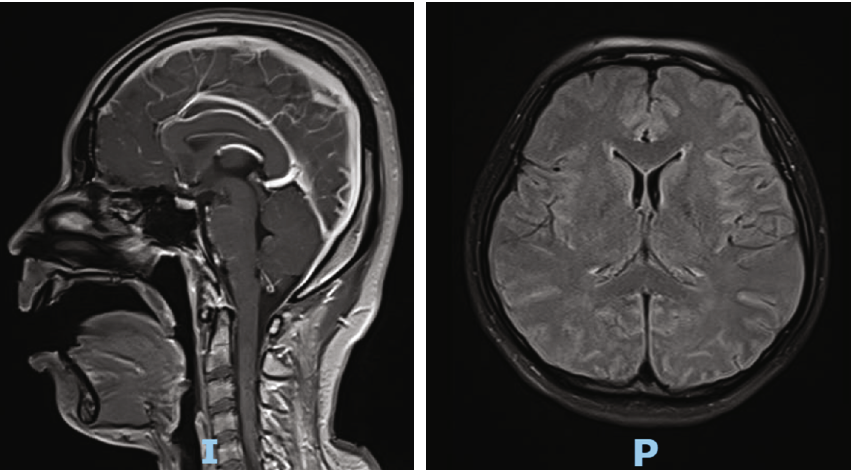
Figure 1: Brain magnetic resonance imaging on the same day of admission to the intensive care unit showed di ff use brain edema and hyperintensity of the bilateral sulcus, gyrus and basal ganglia on fl uid-attenuated inversion recovery (FLAIR), and mildly contrast enhancement of the meninge, compatible with hypoxic-ischemic encephalopathy.